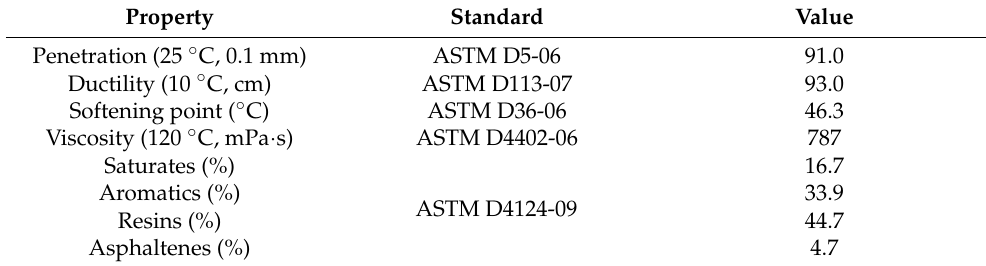
Table 2. Overview of base